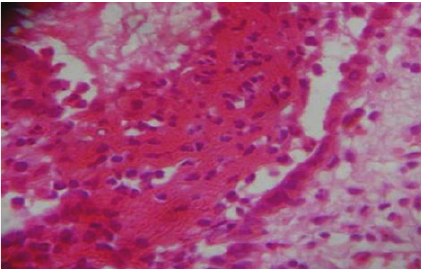
Figure 1: Ulcer on the left buccal mucosa, ovoid in shape.